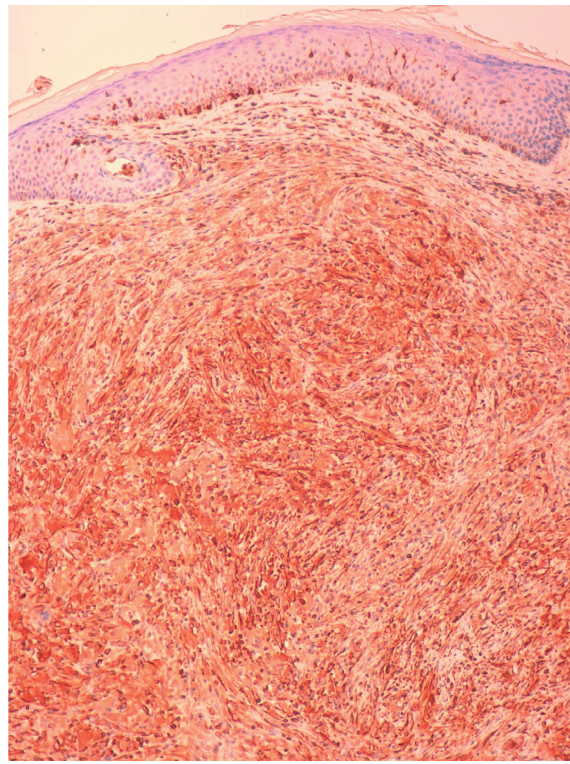
Figure 4: Positivity for vimentin ( × 10).